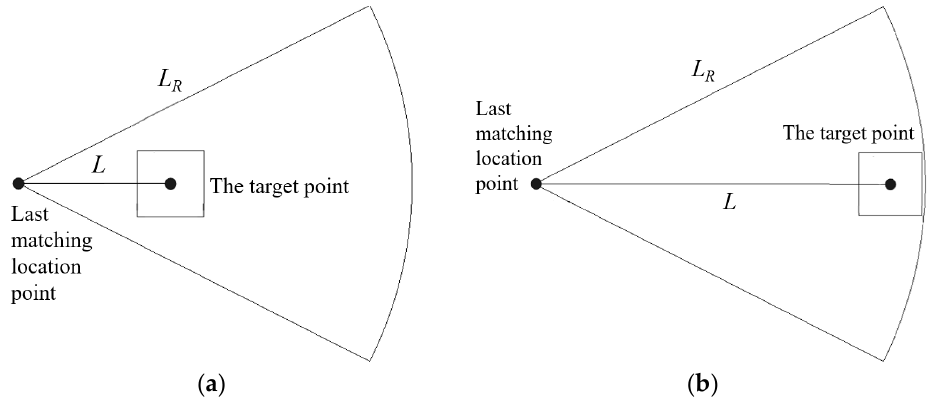
Figure 11. The target point located in the searching area. ( a ) The target point near the central of the searching area; ( b ) The target point at the edge of the searching area.